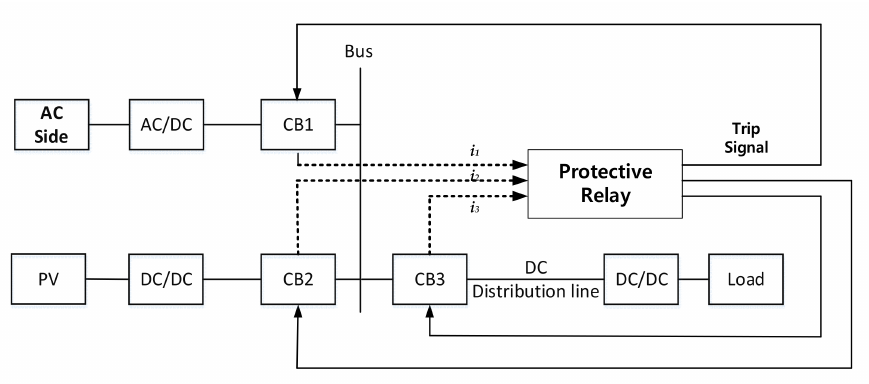
Figure 9. System configuration of proposed new protection